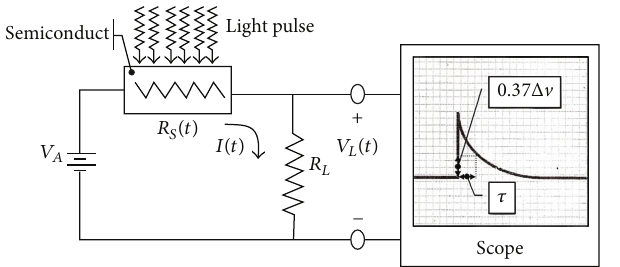
Figure 3: Carrier life time setup.